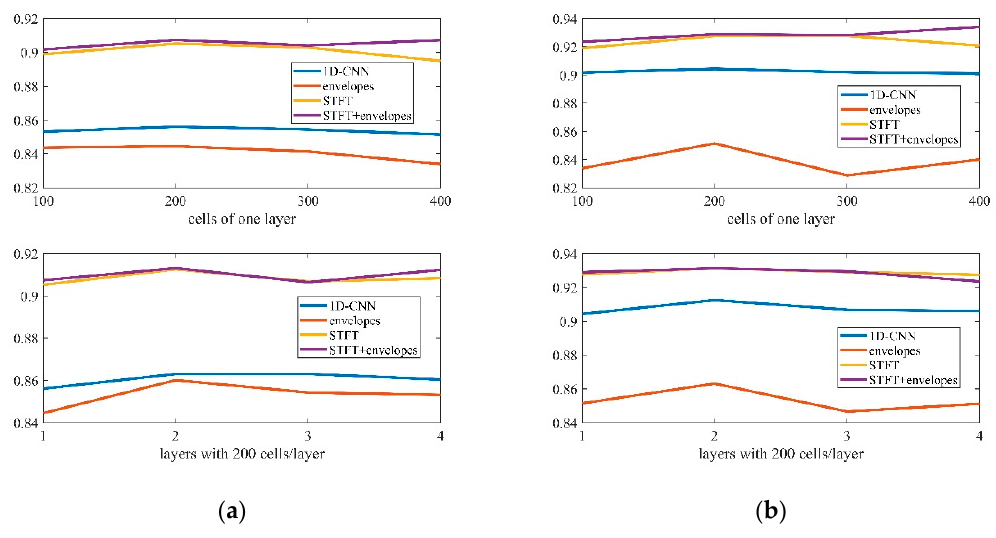
Figure 11. Accuracy of long short-term memory (LSTM) classification results. ( a ) PN-training-a. ( b ) LH-training.